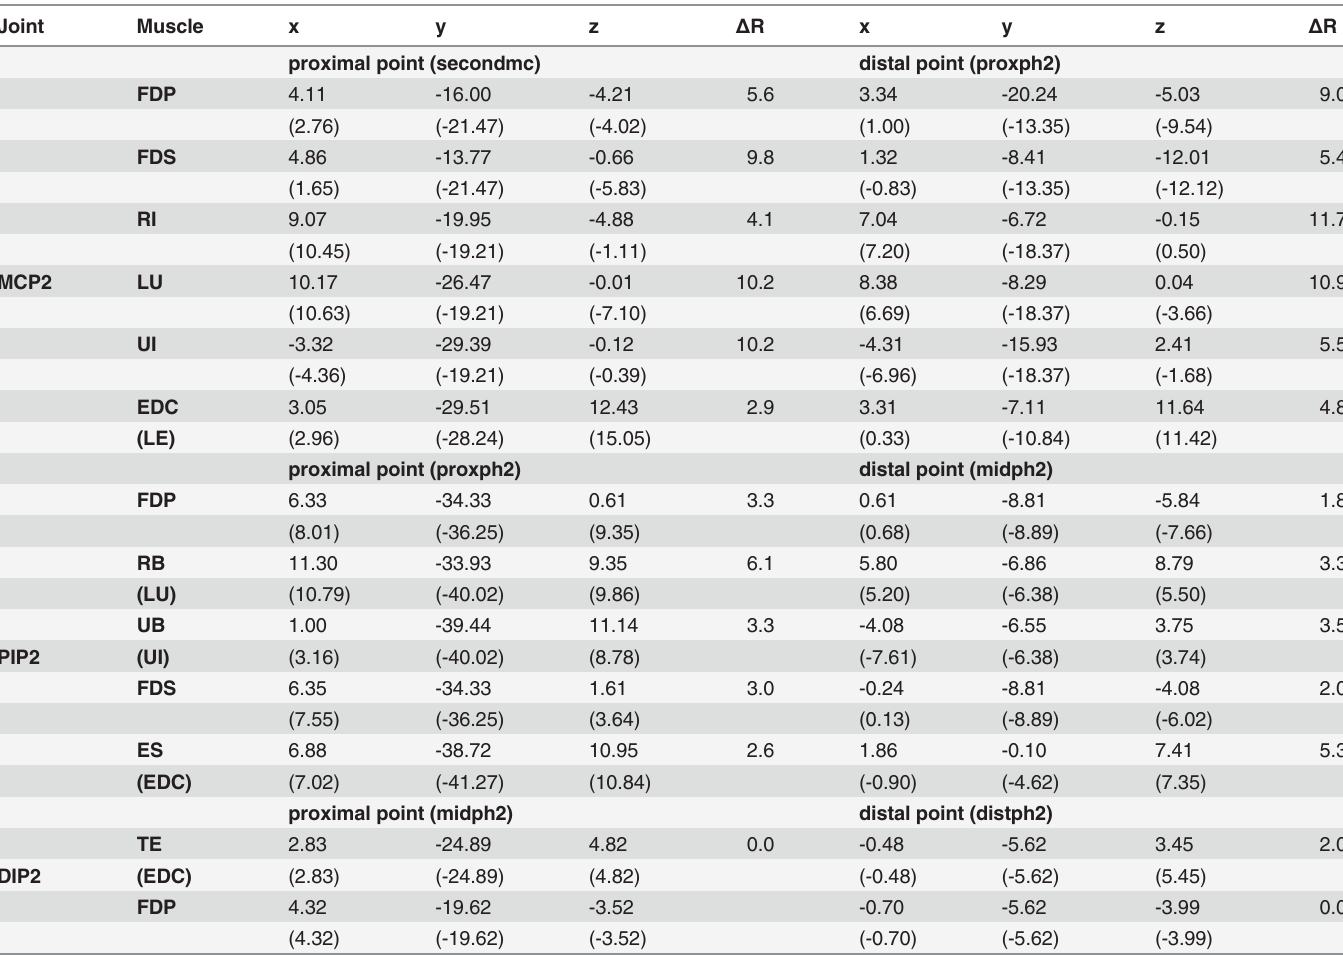
Table 7. Index finger muscle-tendon locations, expressed in OpenSim frame